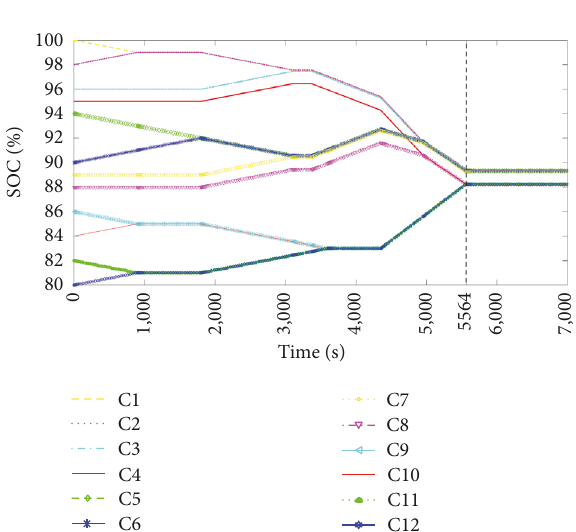
Figure 12: Active cell balancing results using proposed active cell balancing circuit for all cells at 25 ∘